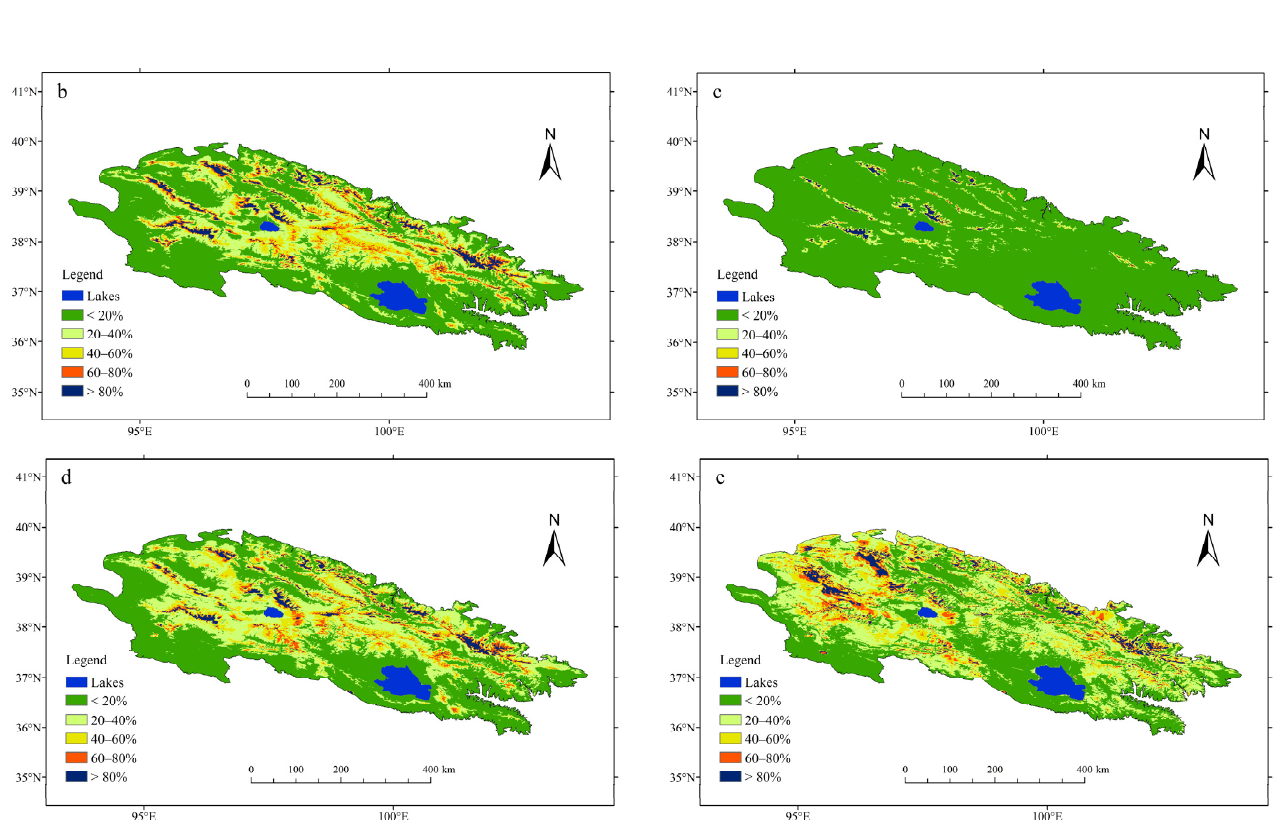
Figure 2. Spatial pattern of mean snow cover frequency in the Qilian Mountains (2000–2020). ( a ) annual; ( b ) spring; ( c ) summer; ( d ) autumn; ( e ) winter.